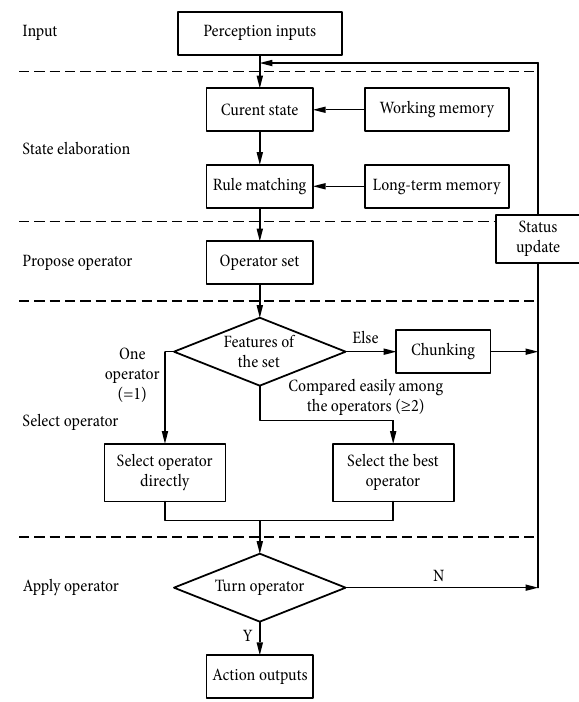
Fig. 6. Decision-making cycle